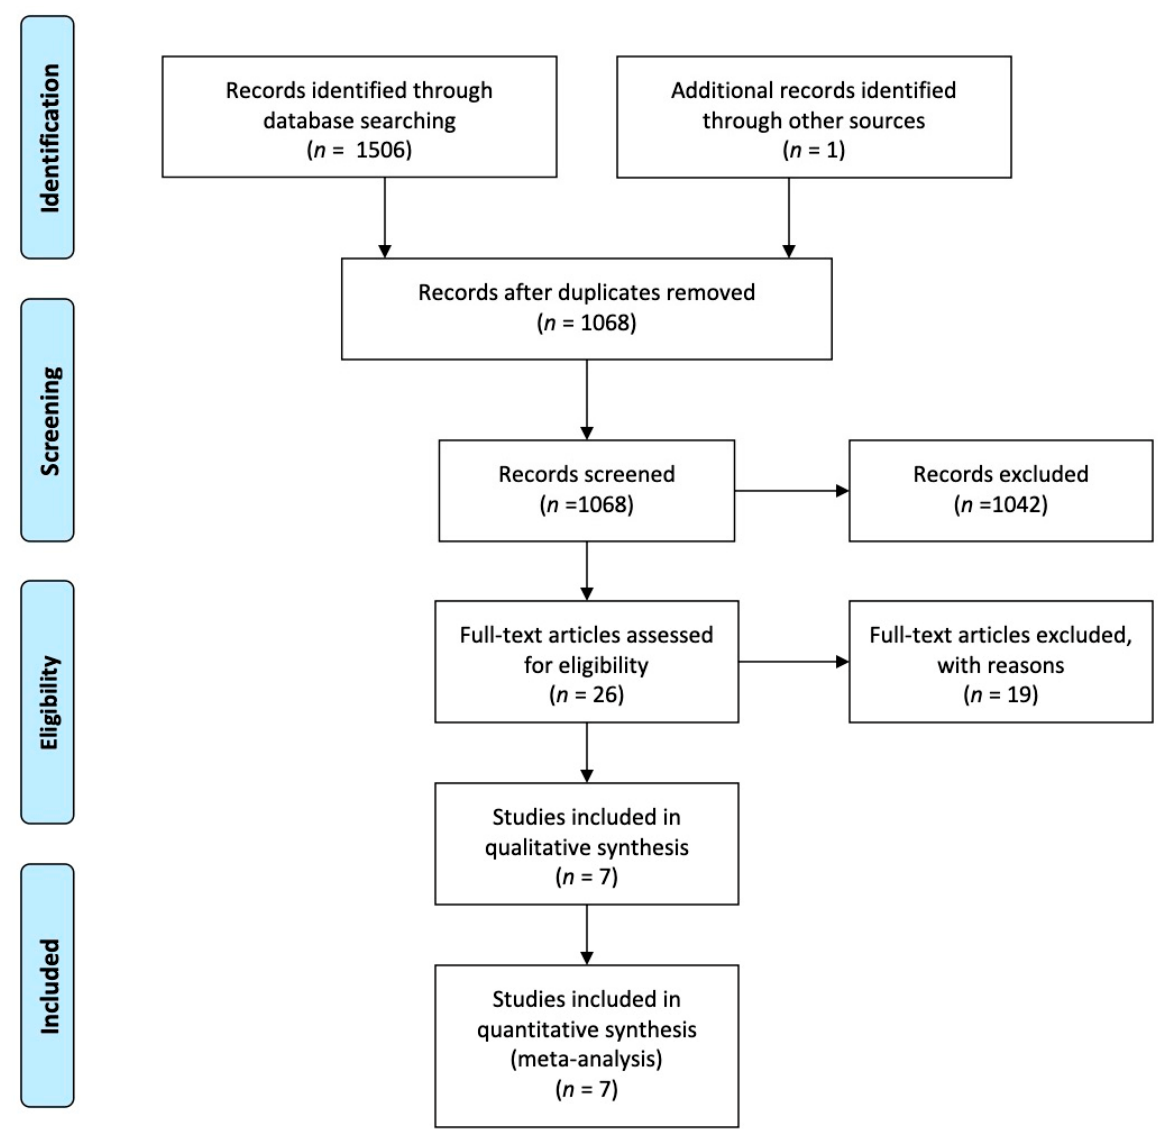
Figure 1. Preferred reporting items for systematic reviews and meta-analysis (PRISMA) flow diagram for study selection.